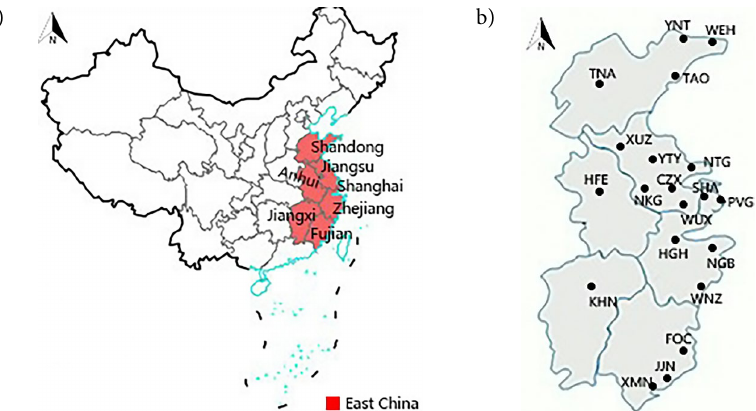
Figure A. Map of East China (a) and top 20 airports in East China (b)